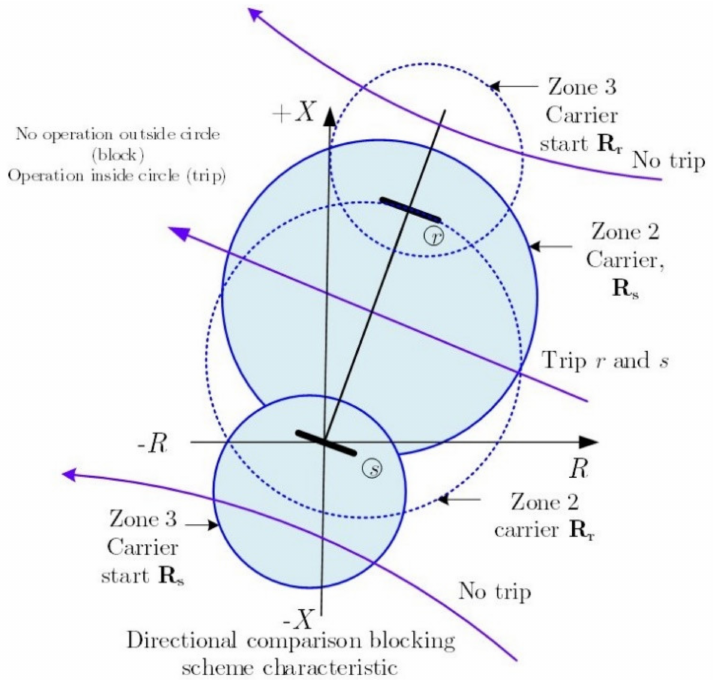
Figure 5. Distance relay characteristic of R s in Figure 1, directional comparison blocking scheme characteristics is